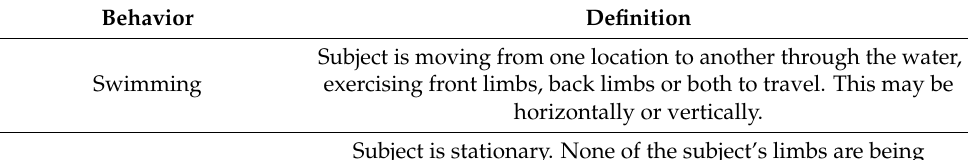
Table 1. Ethogram of state behaviors for captive X. longipes , adapted from work on X. laevis [35].